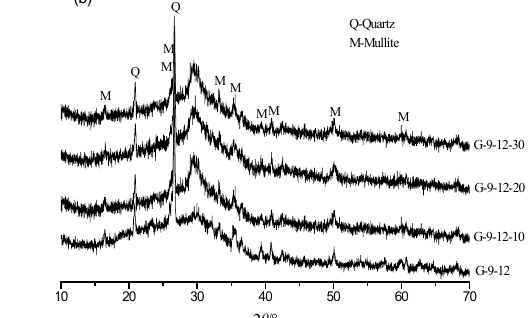
Figure 5. XRD analysis of FA-based geopolymer grouting materials: ( a ) parameters of modified sodium silicate; ( b ) content of GBFS.